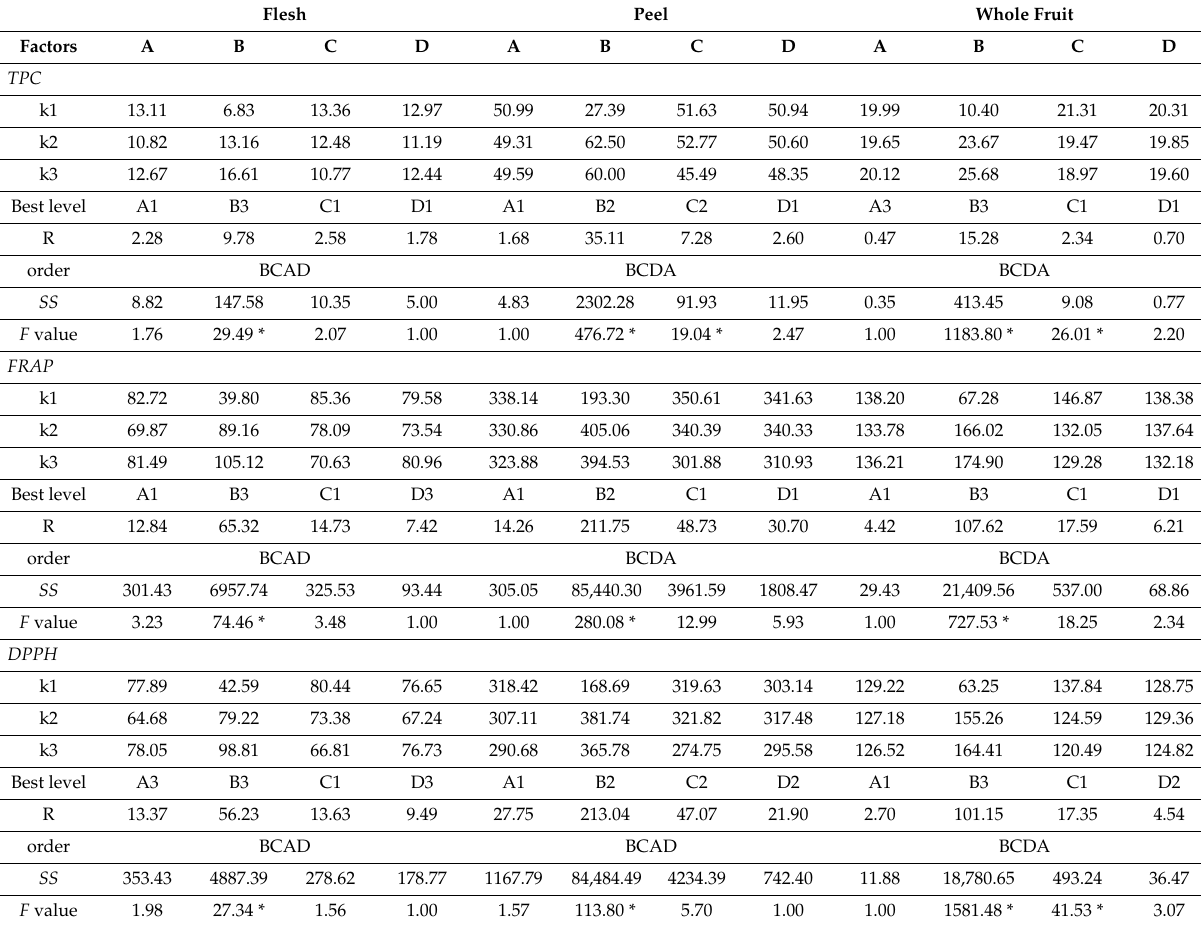
Table 2. Range analysis and analysis of variance (ANOVA) of extraction factors and levels from the orthogonal